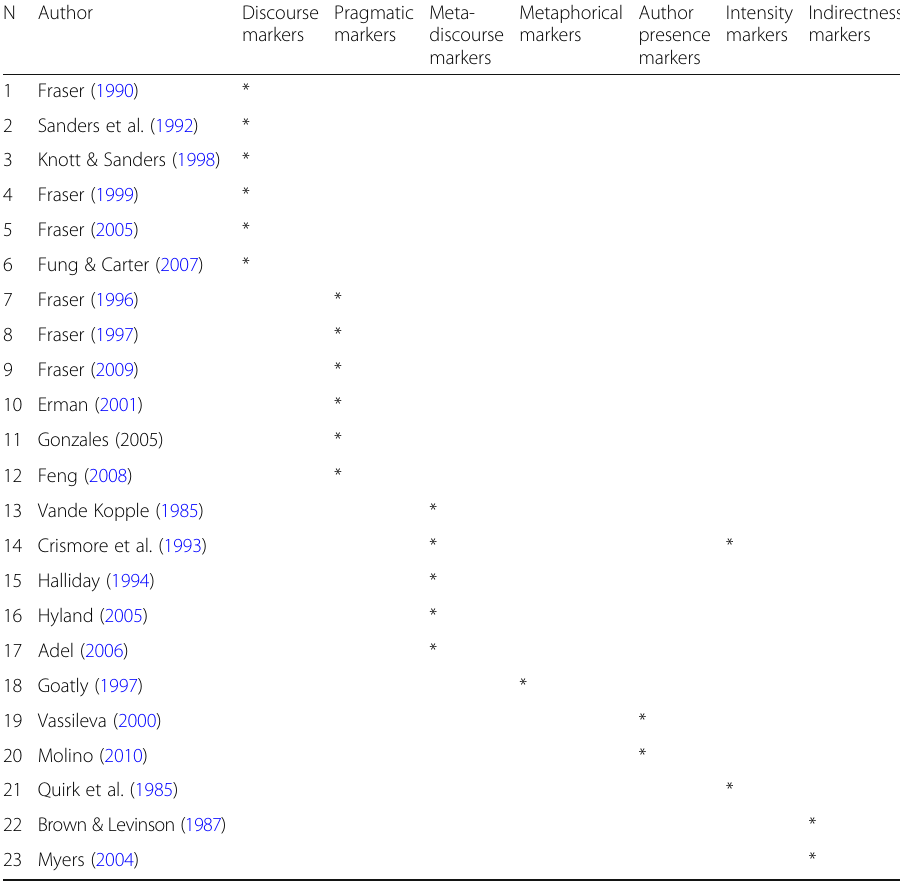
Table 2 A Comparison of Studies in terms of Focused Rhetorical Markers N